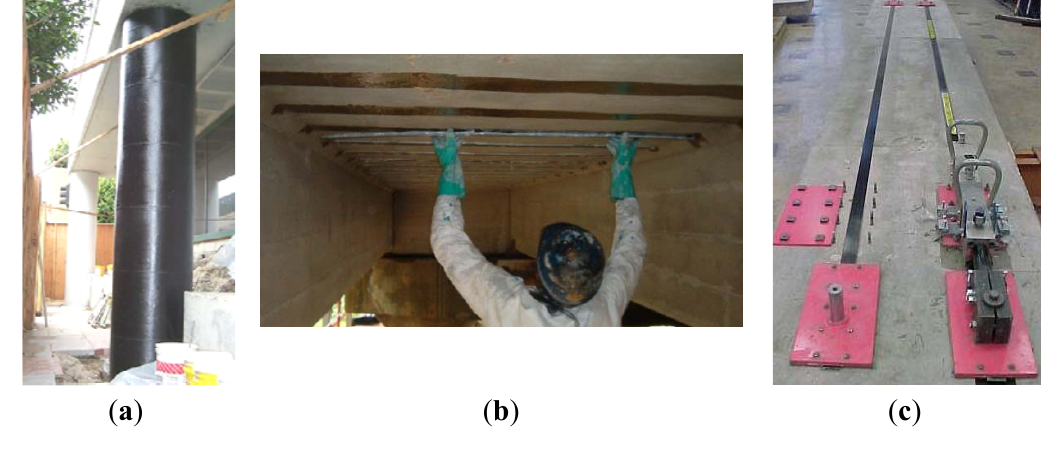
Figure 24. Externally bonded Fiber-reinforced polymer (FRP) installations: ( a ) Manual lay-up for column confinement; ( b ) Bonded plate for flexural upgrade; ( c ) Plate pre-tensioning